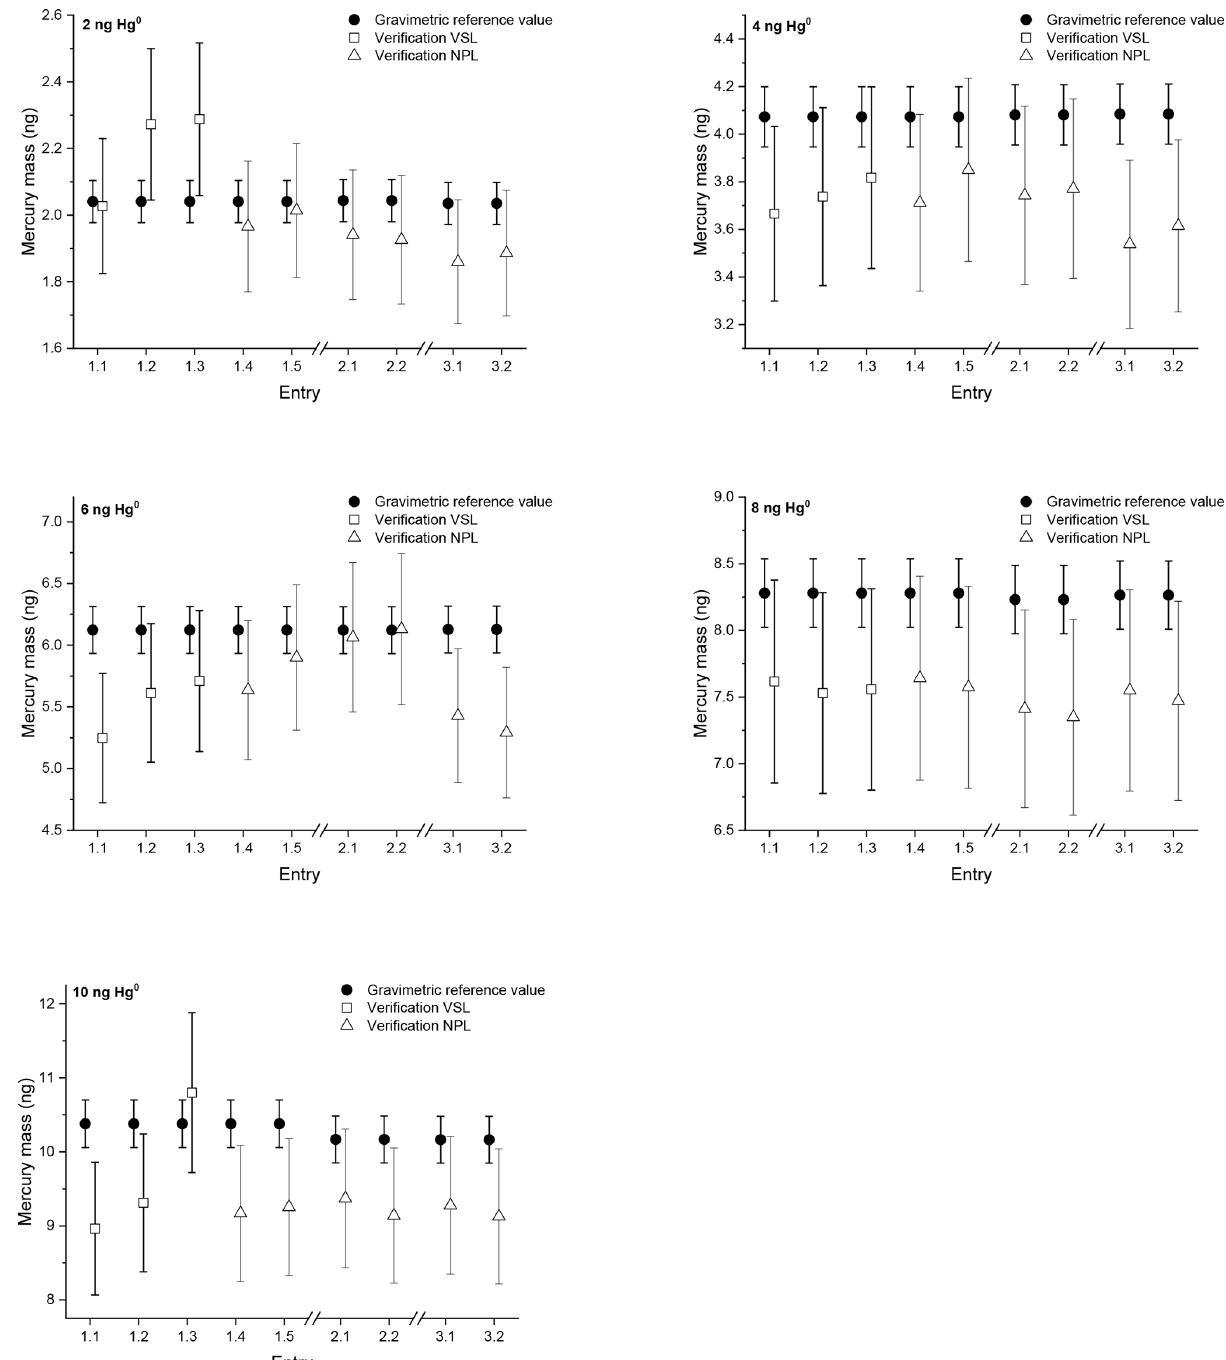
Figure 1. Verification results of the first comparison with mercury amounts of approximately 2, 4, 6, 8 and 10ng on sorbent tubes. The open squares and triangles are the results from the measurements calibrated using the Dumarey equation. The closed circles are the reference values determined gravimetrically. The error bars indicate the expanded uncertainty for the reference values (ng) ( k = 2) and the verification values (ng) ( k = 2). Entries 1.1, 1.2 and 1.3 show the verification results of VSL from the first round. The verification results of NPL in